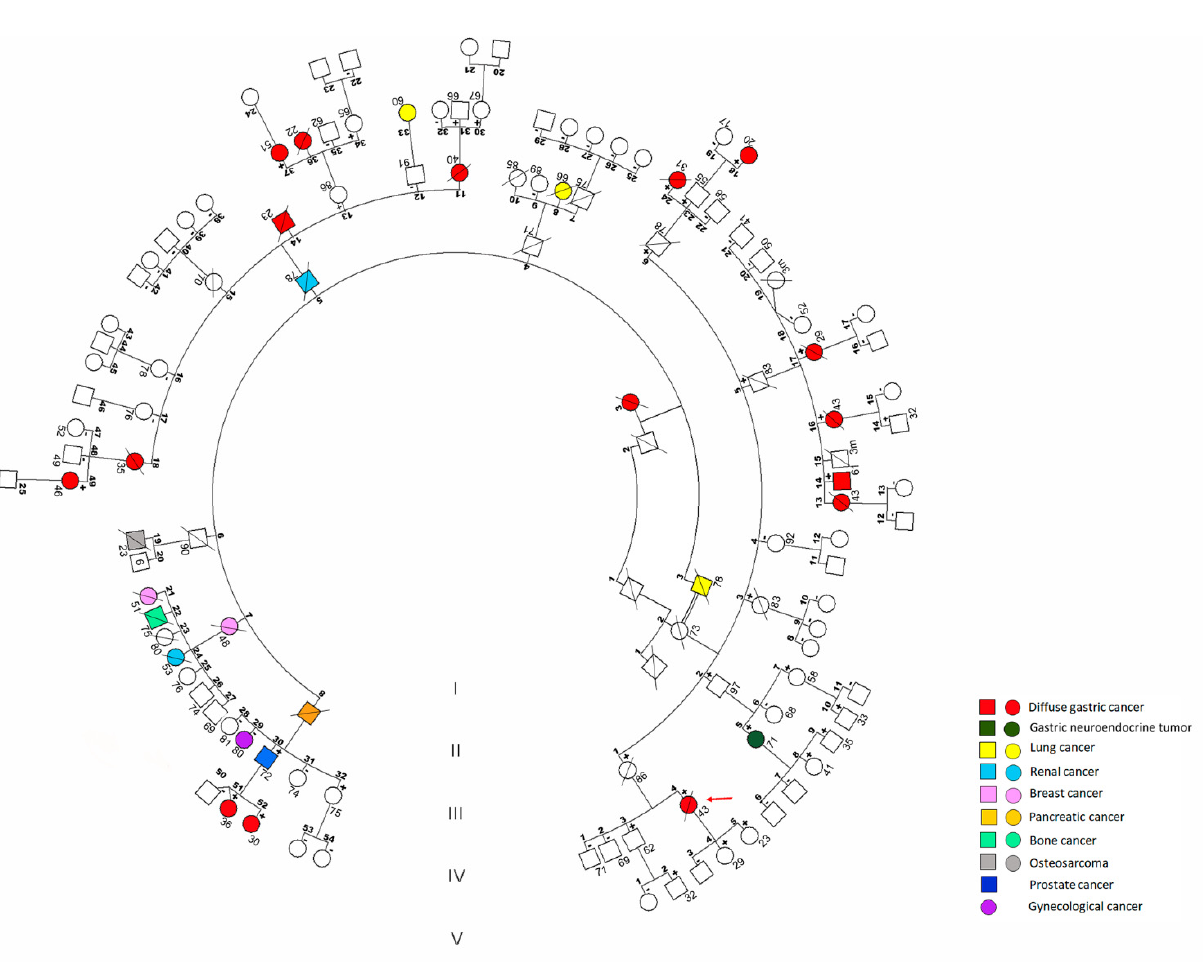
Figure 1. Clinical presentation associated with the G212E E-cadherin variant. Pedigree illustrating variant segregation and disease phenotypes within a family structure along five generations (I-V). For simplicity, individuals were numbered in each generation. Squares indicate males and circles indicate females. Symbols with a slash denote deceased individuals. Symbols + or − in the upper right corner represent the result of CDH1 variant screening. The proband is identified with a red arrow. Cancer types affecting family members are specified by color. The actual age (May 2021) or the age at the time of death is displayed below each individual. m stands for